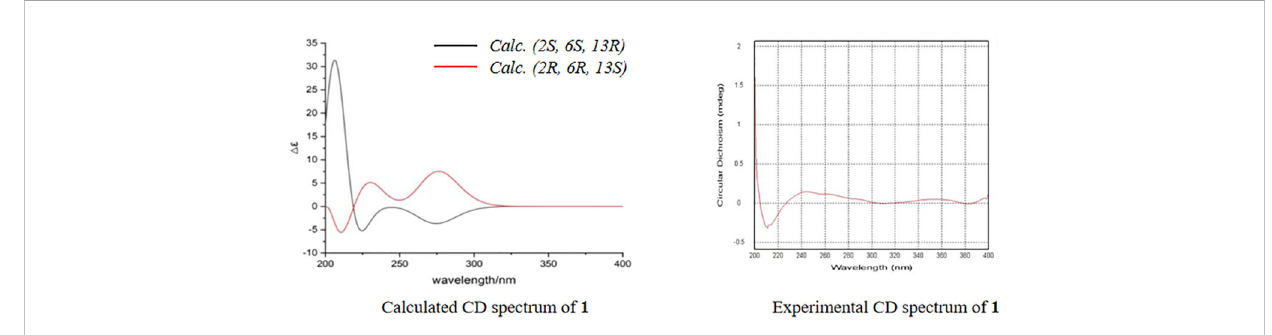
FIGURE 3 Calculated and experimental circular dichroism spectrum of compound